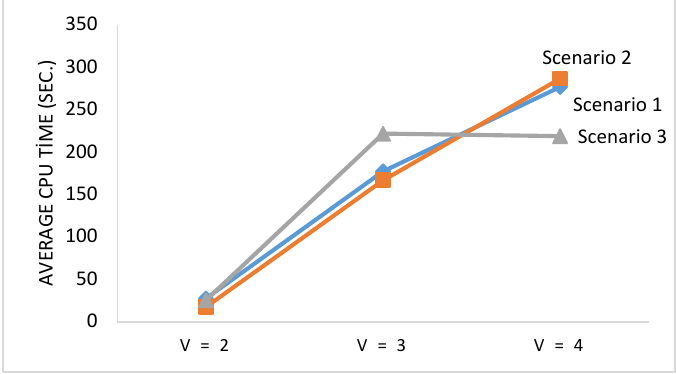
Fig. 6. Effect of 𝑉 on the average CPU times for 𝑇 = 6 (MILP-C